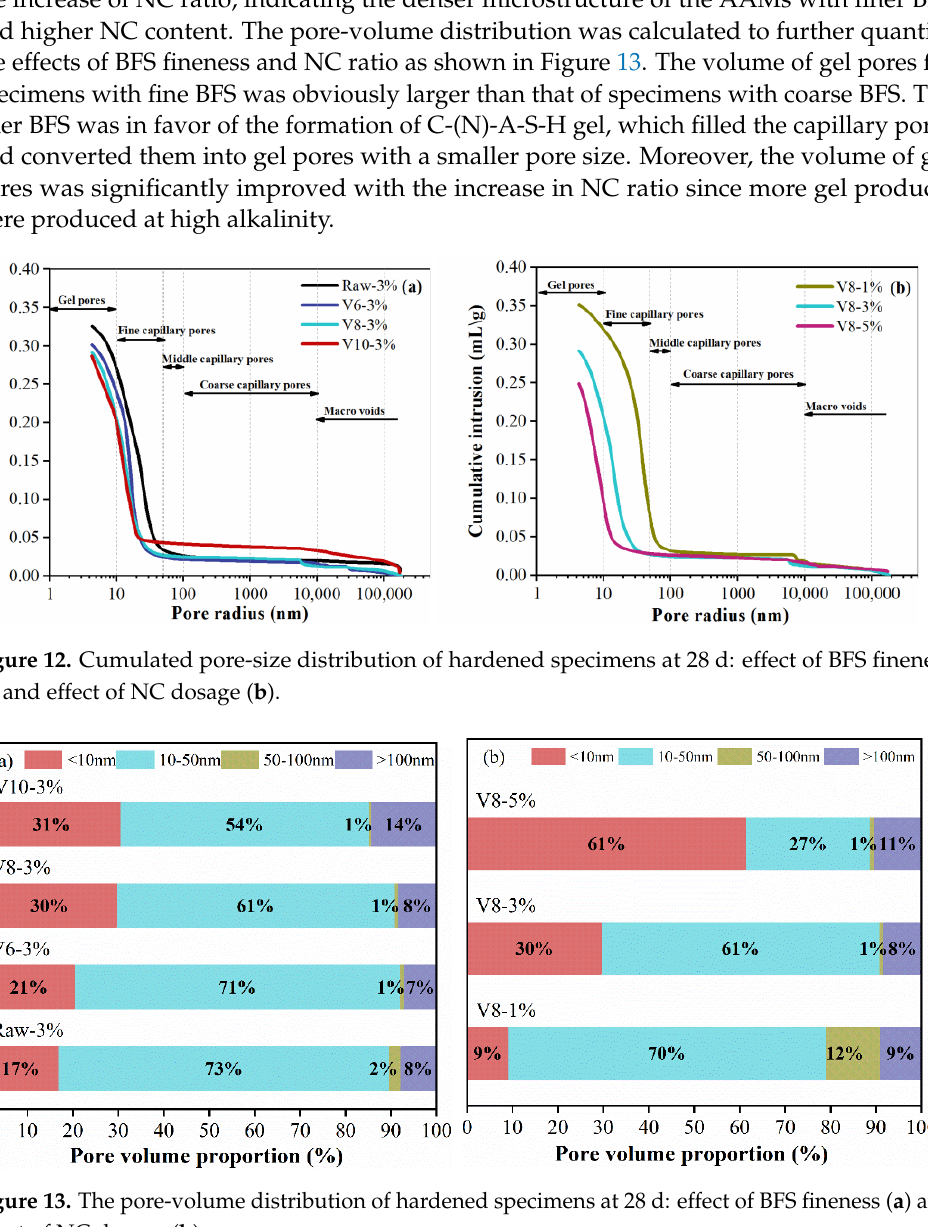
Figure 13. The pore-volume distribution of hardened specimens at 28 d: effect of BFS fineness ( a ) and effect of NC dosage ( b ).